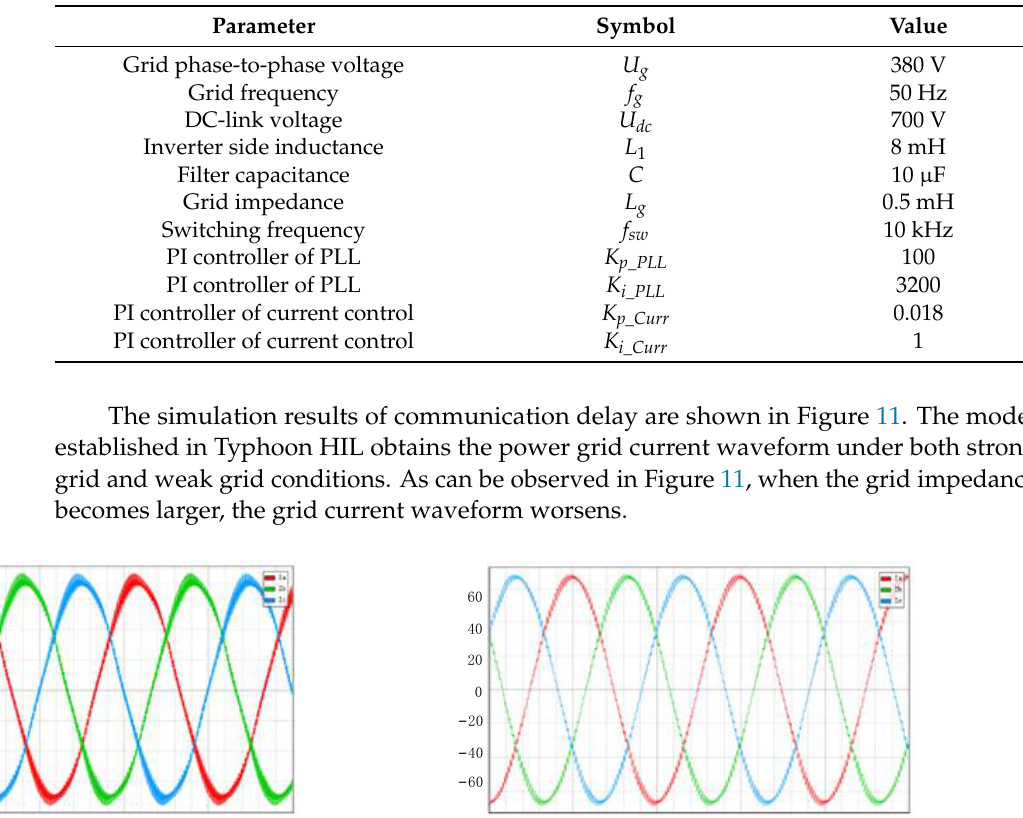
Table 4. Specifications of the Grid-tie Inverters.